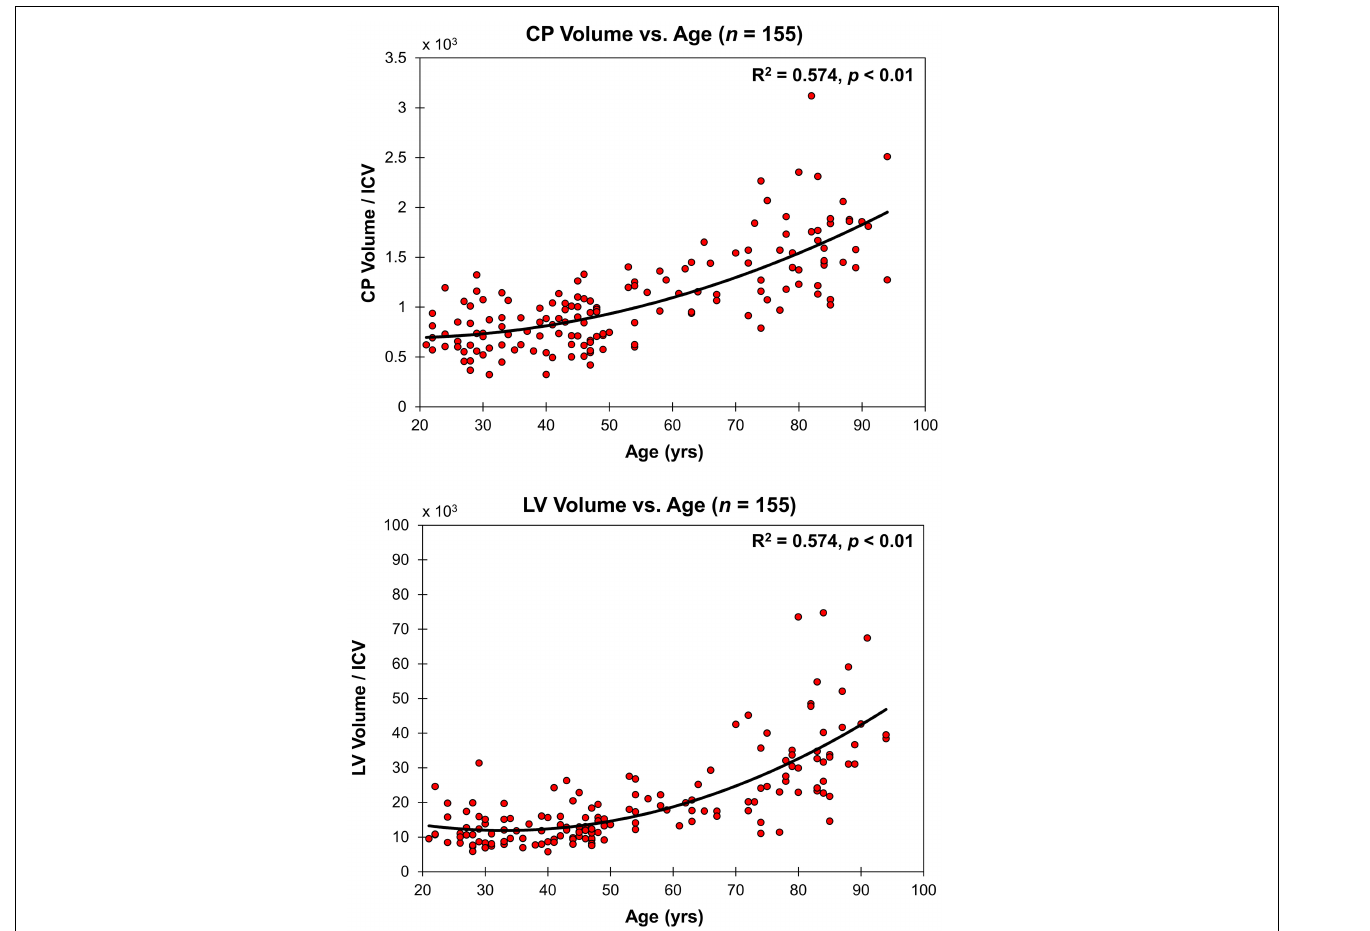
FIGURE 2 | Regressions of CP and LV volumes, after correcting for total intracranial volume (ICV), with age. For each plot, the coefficient of determination, R 2 , and p -value, p , are reported. LV and CP volume showed non-linear increases with age.